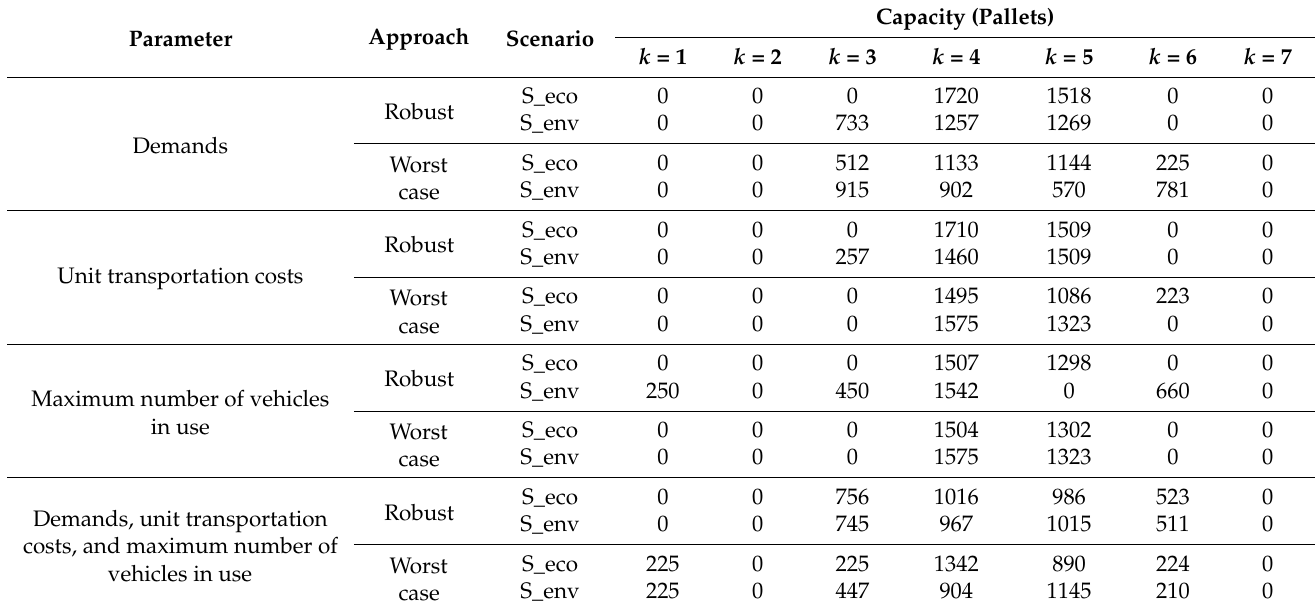
Table 9. Capacities of downstream hubs